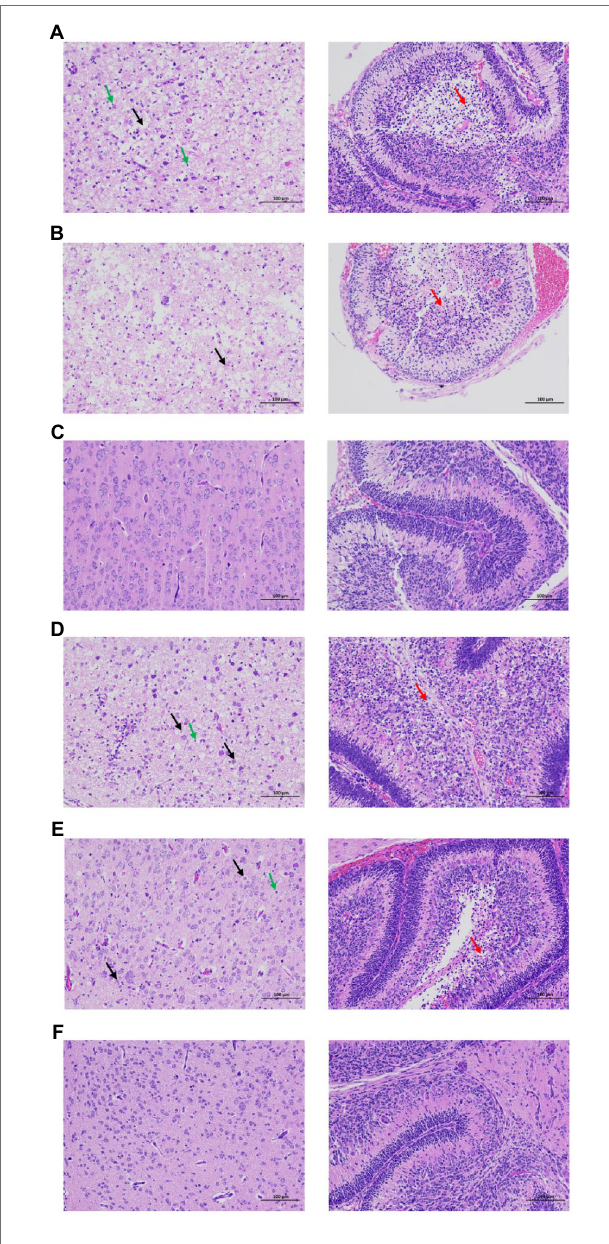
FIGURE 6 | Brain pathological analysis of the C57BL/6 and Kunming neonatal mice infected with rZKC2 and pZKC2. Both moribund C57BL/6 and Kunming suckling mice had massive neuronal necrosis in the brain (black arrows), with pyknotic, fragmented, and obliterated nuclei, leaving empty spaces in the cytoplasm. Furthermore, minor neutrophil and lymphocyte infiltration (green arrows) was observed. In the cerebellum, more granular layers of cells were focally necrotic, and the nuclei were pyknotic and fragmented, and disappeared subsequently (red arrows). The morphology of nerve cells in the control group was normal, and no inflammatory cell infiltration was observed. (A) C57BL/6 neonatal mice infected by rZKC2; (B) C57BL/6 neonatal mice infected by pZKC2; (C) C57BL/6 neonatal mice control group. (D) Kunming neonatal mice infected by rZKC2; (E) Kunming neonatal mice infected by pZKC2. (F) Kunming neonatal mice control group. Results from one independent experiment using six pZKC2 and rZKC2 infected neonatal mice brains and three uninfected controls were